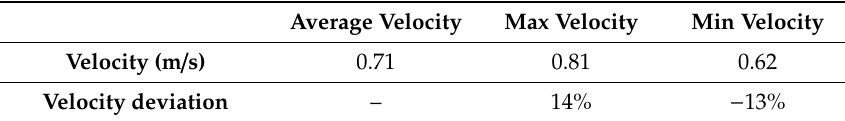
Table 3. Averages and deviations of the velocity